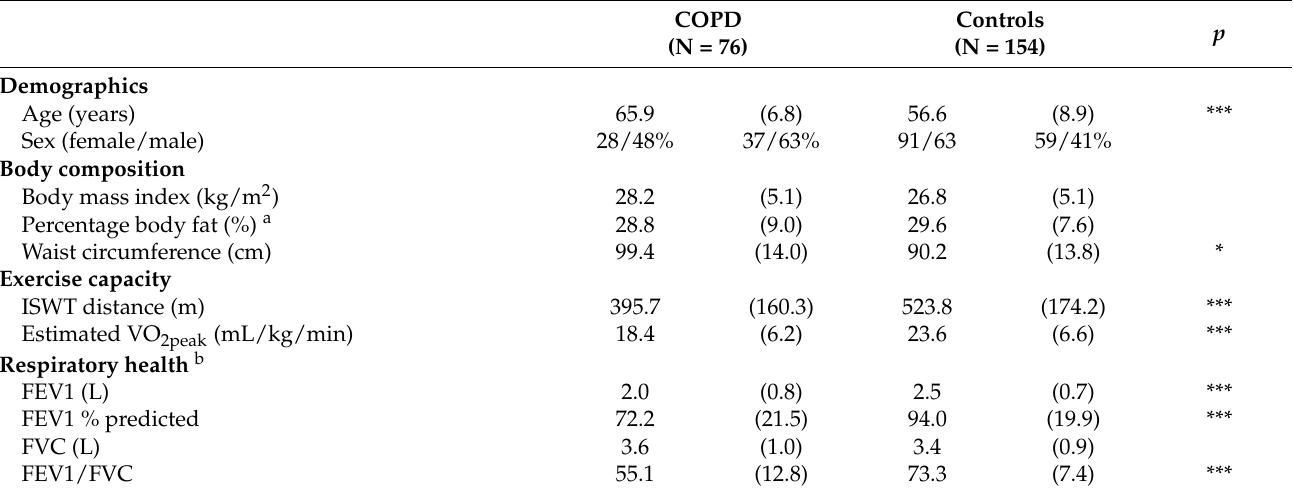
Table 1. Characteristics of the sample, reported as mean (SD) unless otherwise stated.